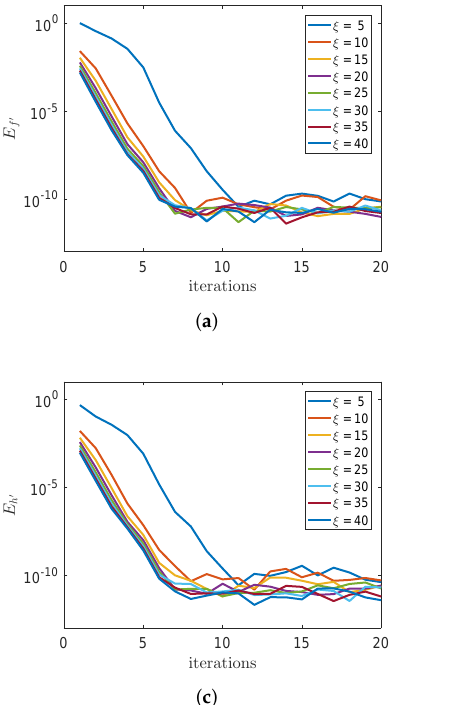
Figure 2. Error in ( a ) f ( η , ξ ) ( b ) θ ( η , ξ ) , and ( c ) h ( η , ξ ) for different values of ξ .